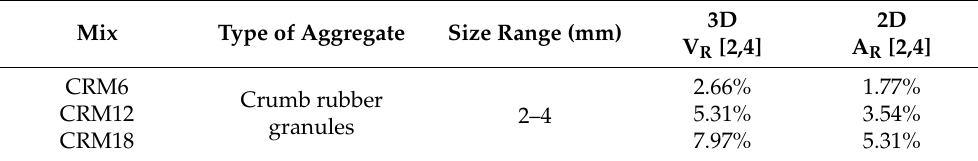
Table 3. 3D gradation and 2D design of crumb rubber particles in CRM mortar.